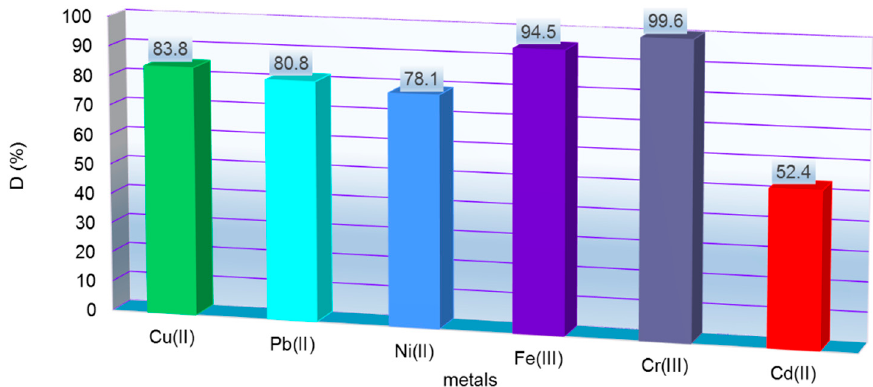
Figure 7. Desorption of M X+ from MS after adsorption process.